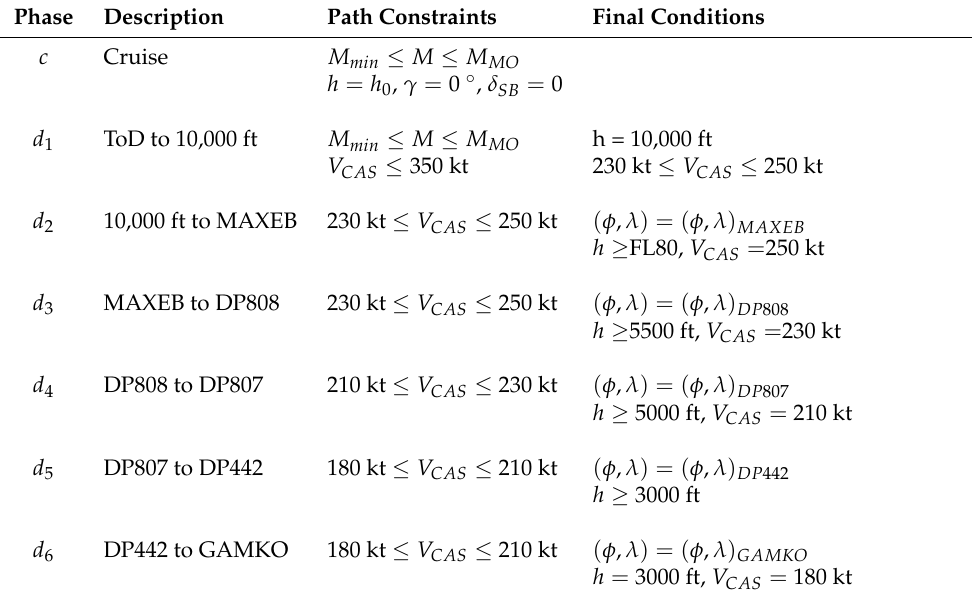
Table 3. Phases and phase-specific constraints.